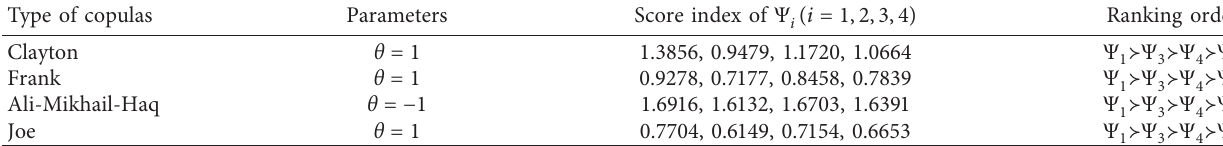
Table 4: The ordering results of alternatives using other different copulas.